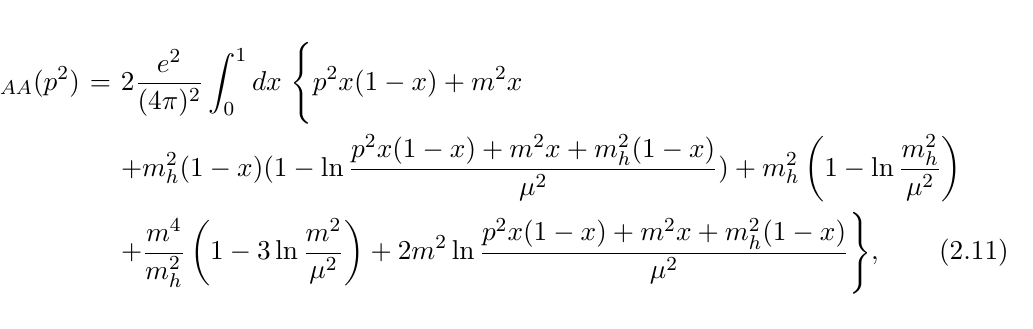
with the self-energy given